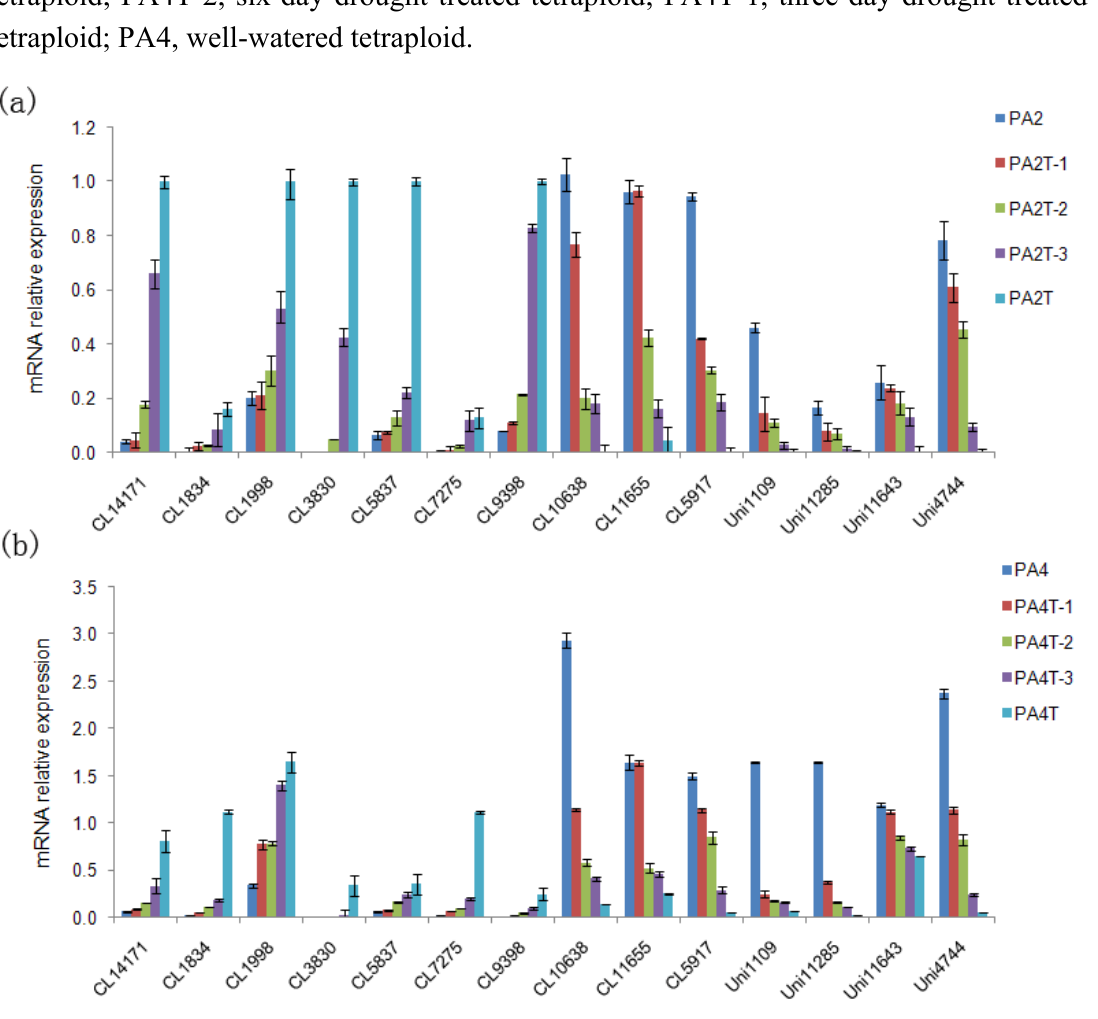
Figure 7. Quantitative Real-Time PCR (qRT-PCR) analysis of 14 potential drought